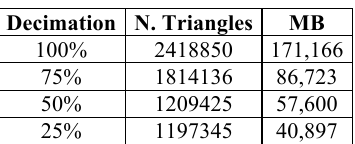
Table 2. Progressive decimated datasets for surface